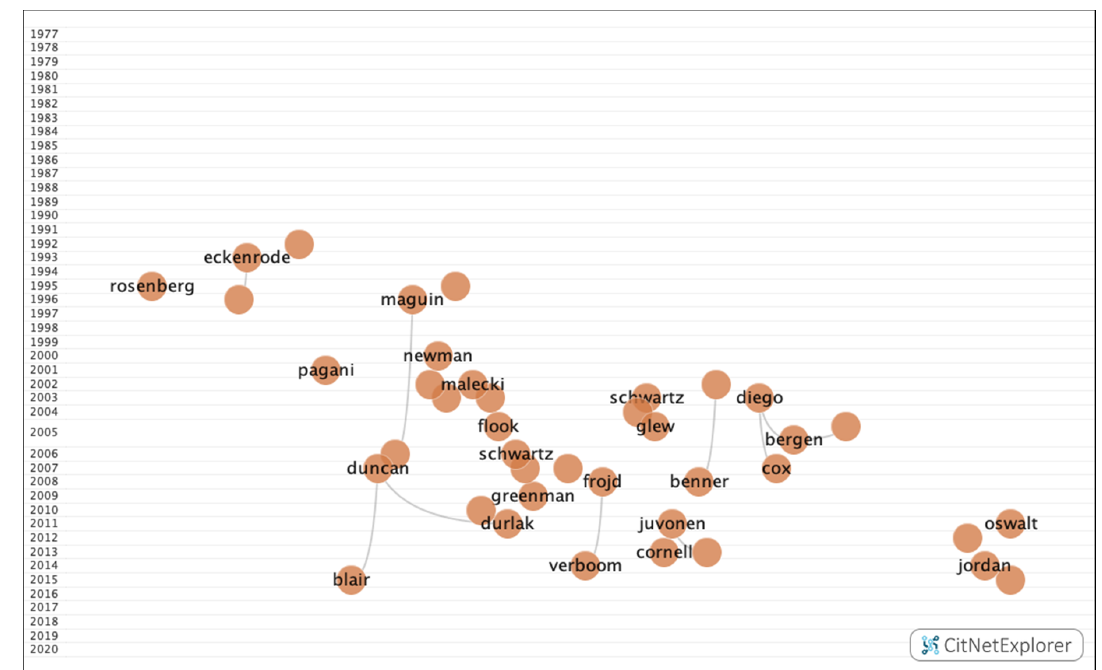
Figure 12. Group 6 citation network. Int. J. Environ. Res. Public Health 2020 , 17 , x